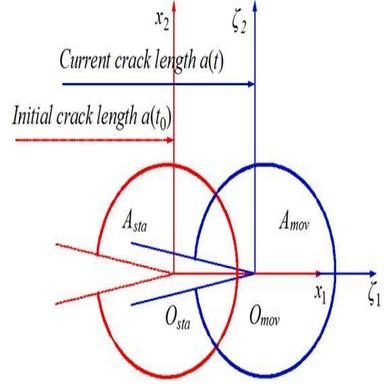
Two different coordinate systems and corresponding contours.